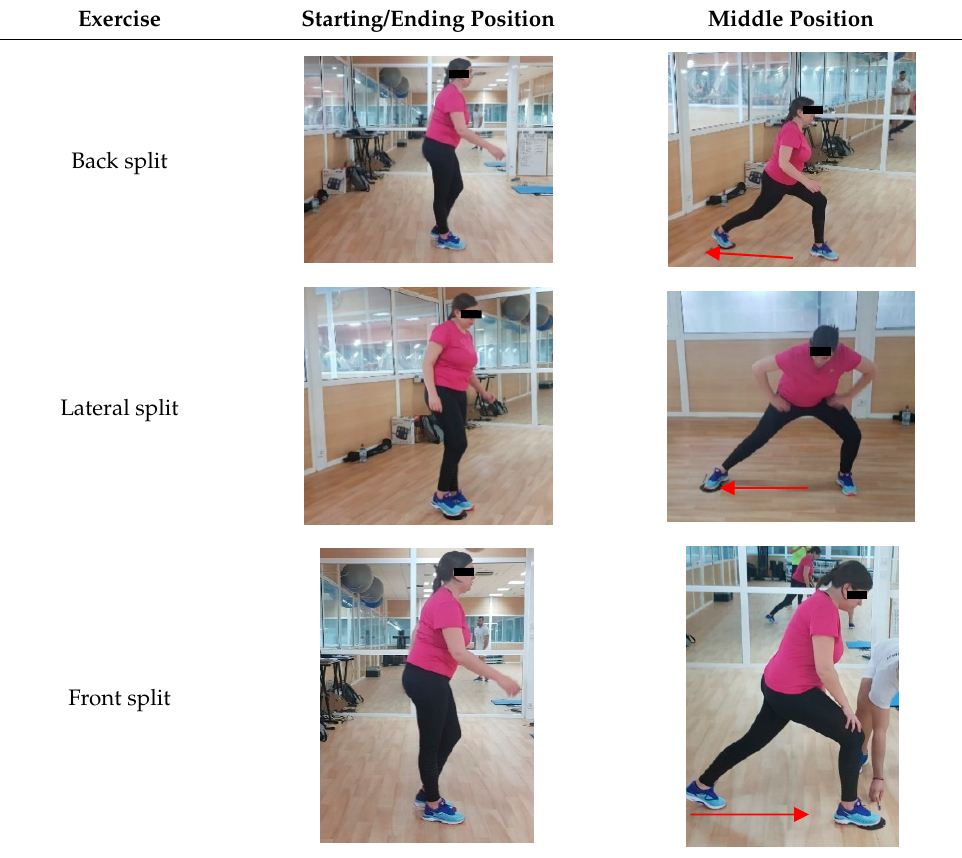
Table 1. Main part of the training.